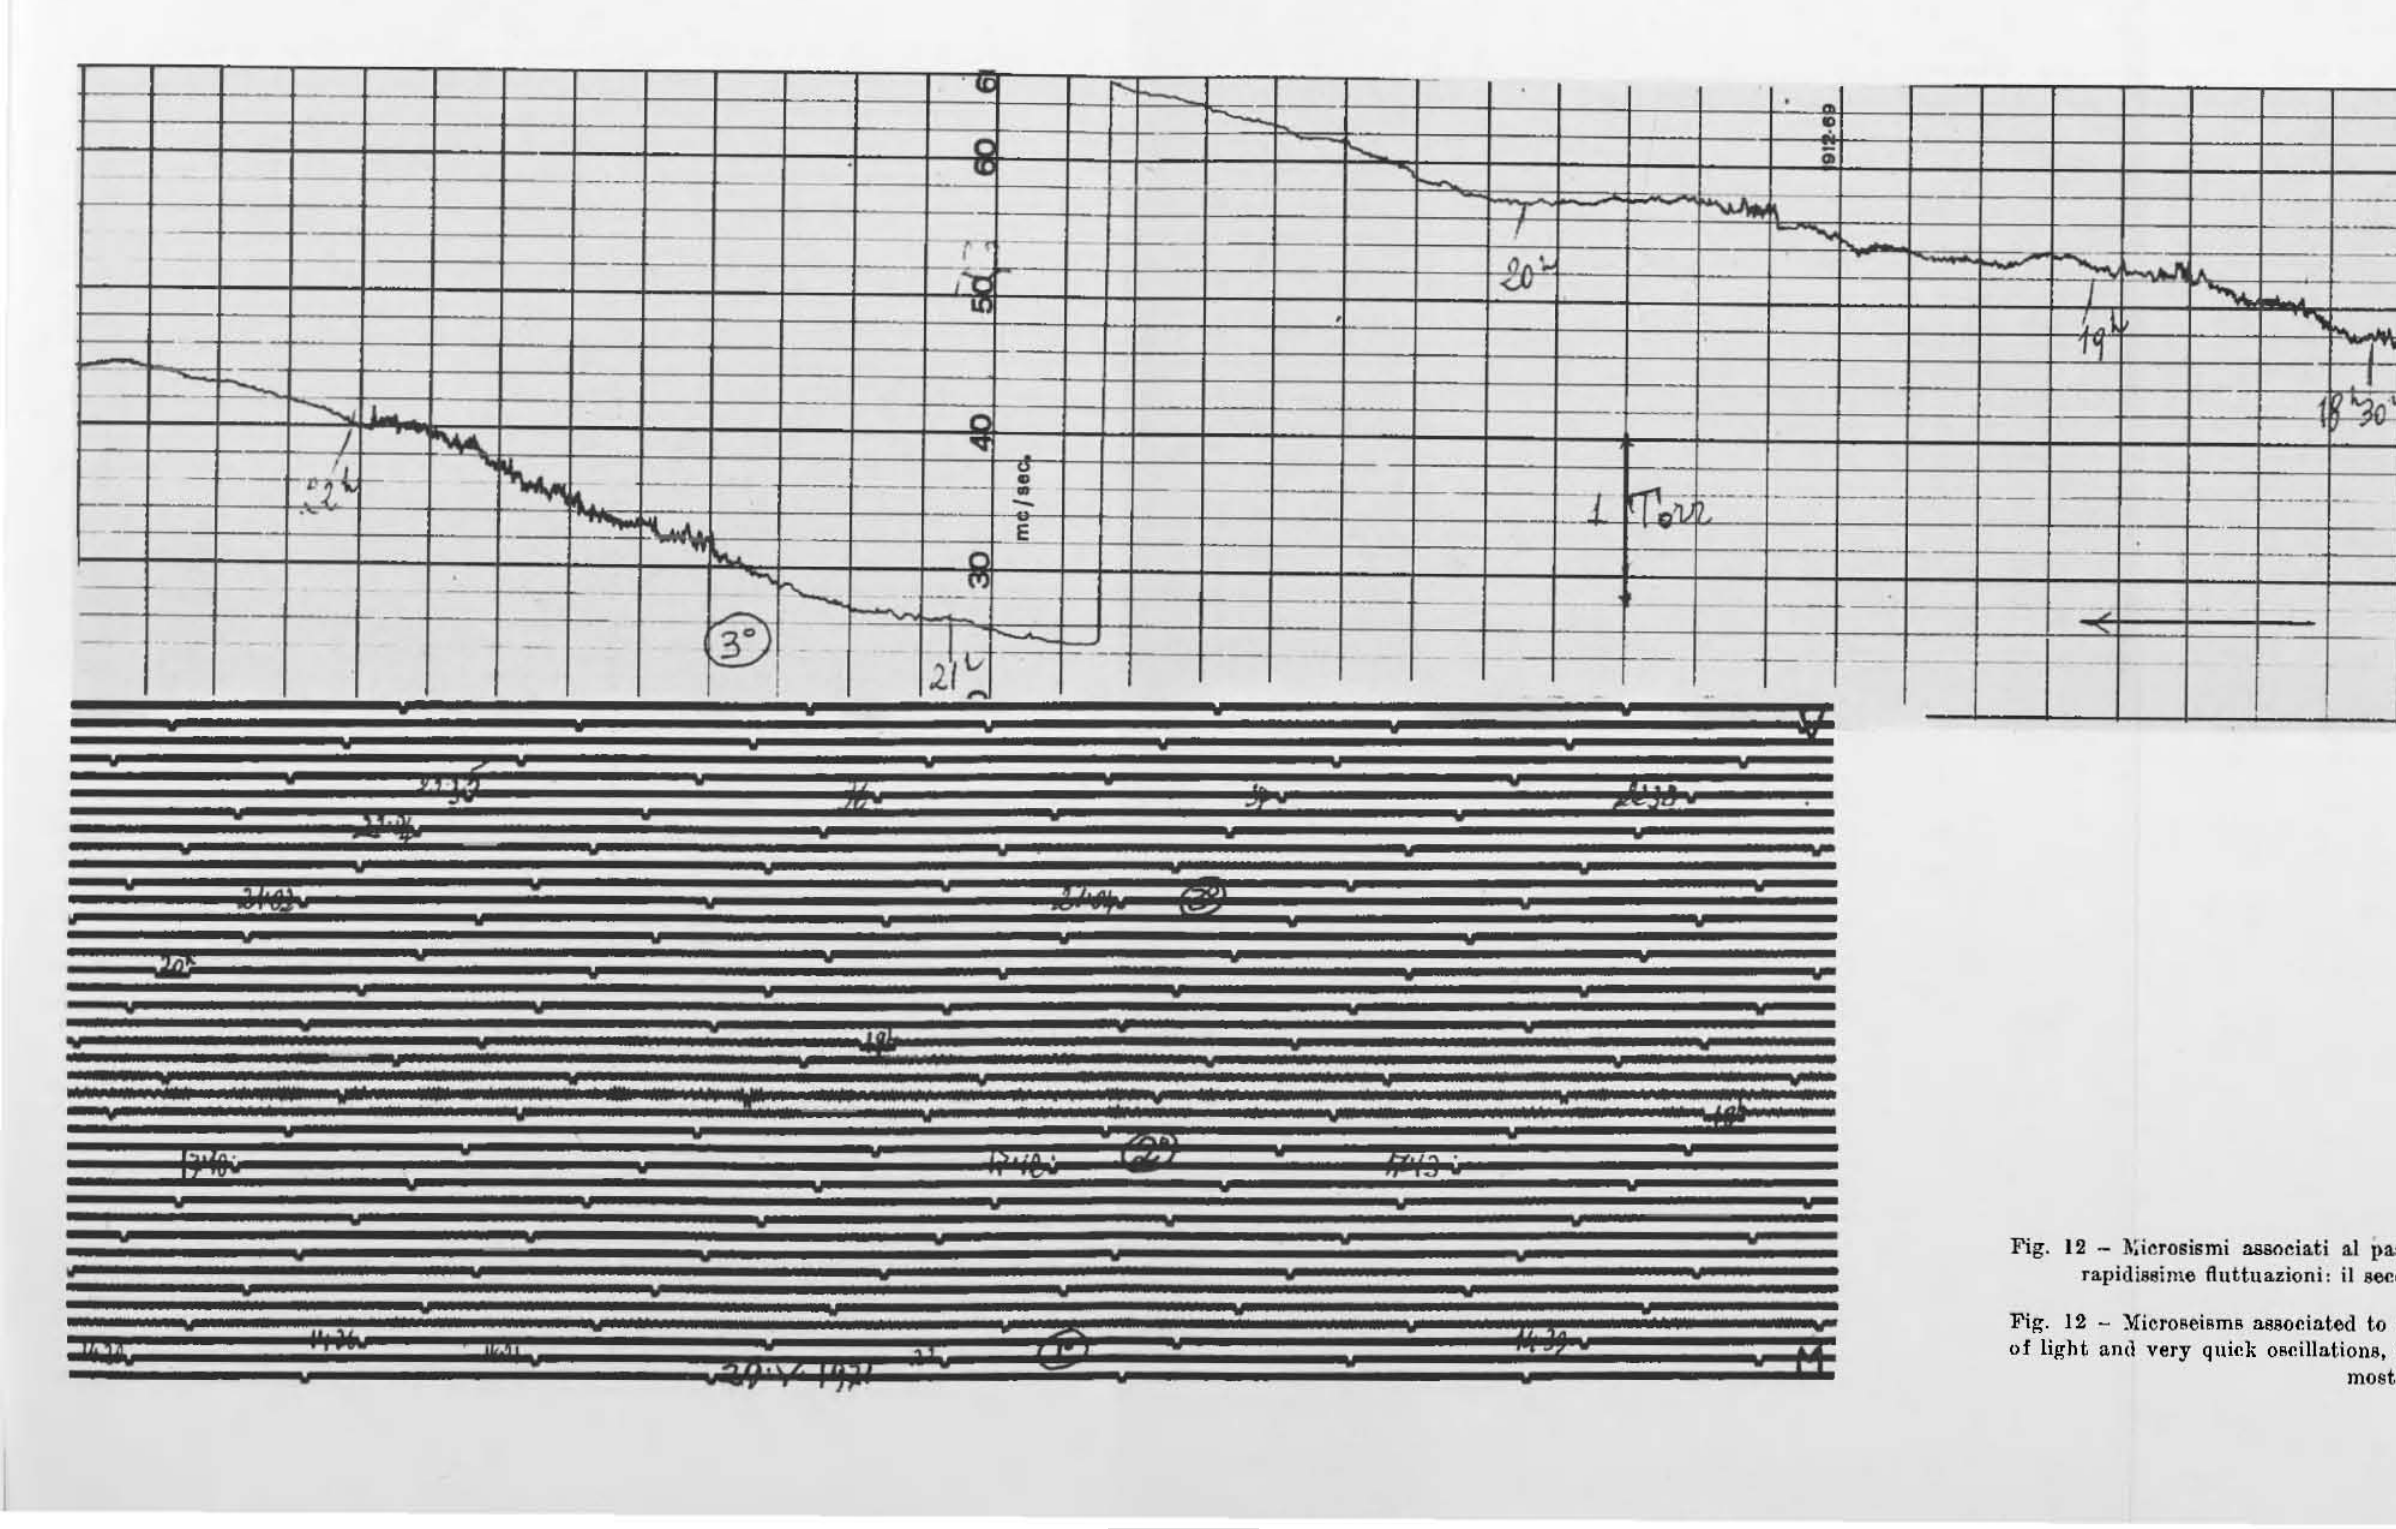
Fig. 12 - ~:ier08illmi :w;oeiati al Jlas~llggio di tre gruppi 8U(,(,611Sivi di lievi. rapidiNilllf> fluttuazioni , il 8~ondo appare nettamente i1 Ilil\ attivo. Fig. 12 - )ficroseisffiB associate<! to tlle pas"age of three ~uccel'.f;ive grOl1p8 ~ most